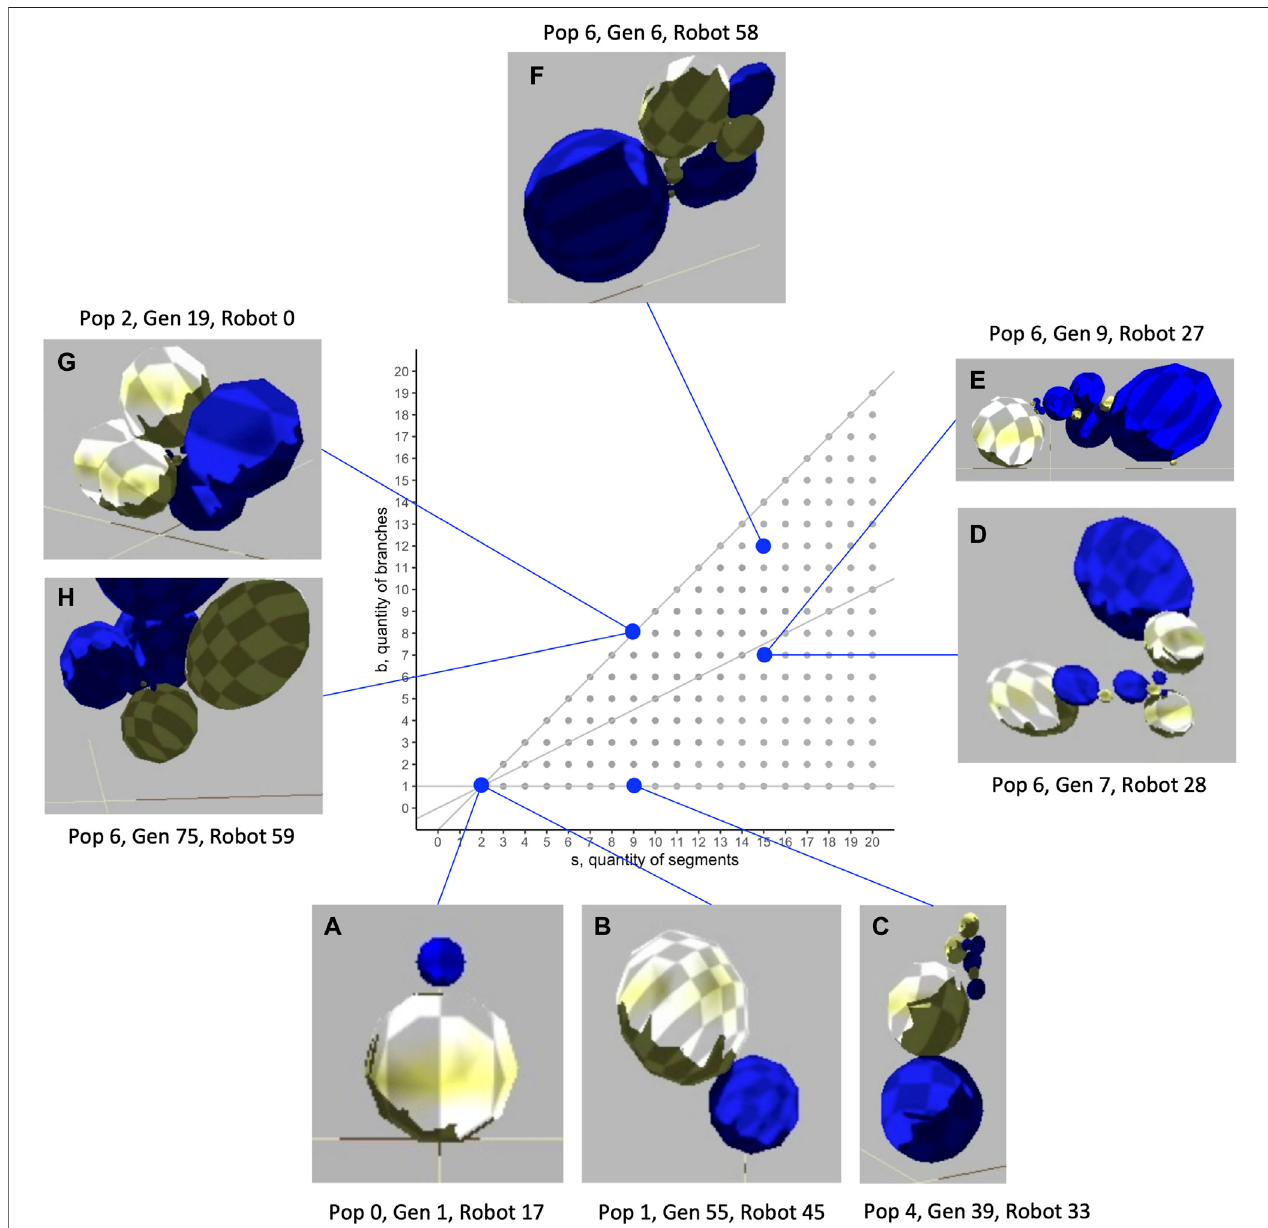
FIGURE1 | Morphological diversity ofevolved biorobots in the segment-branch morphospace. These biorobots were chosen to highlight the range of mechanical morphologies that were evolved and to show the indeterminate relation that sometimes exists between morphology and fi tness. While two robots both have two segments and one branch (A, B) , Robot A fails to move (lack of a motorized joint; fi tness, w (cid:1) 0), while Robot B moves by fl exing the joint (not shown) between the spheres, rotating, and bouncing away ( w (cid:1) 360 ) . Robot (C) is elongated, with a single branch and multiple segments ( w (cid:1) 132 ) . Intermediate in form between elongatedanddendroidalbody architectures areRobots (D) ( w (cid:1) 70 ) and (E) ( w (cid:1) 11 ) .Dendroidalforms, withalmost asmany branchesand segments,areshown by Robots (F) ( w (cid:1) 39 ) , (G) ( w (cid:1) 4 ) , and (H) ( w (cid:1) 172 ) . Spherical segments are distorted in some views because of the wide-angle effect of the camera view. Videos of each robot may be found in the supplemental materials. All biorobots were selected from the experimental treatment of 0.0035 mutation rate.